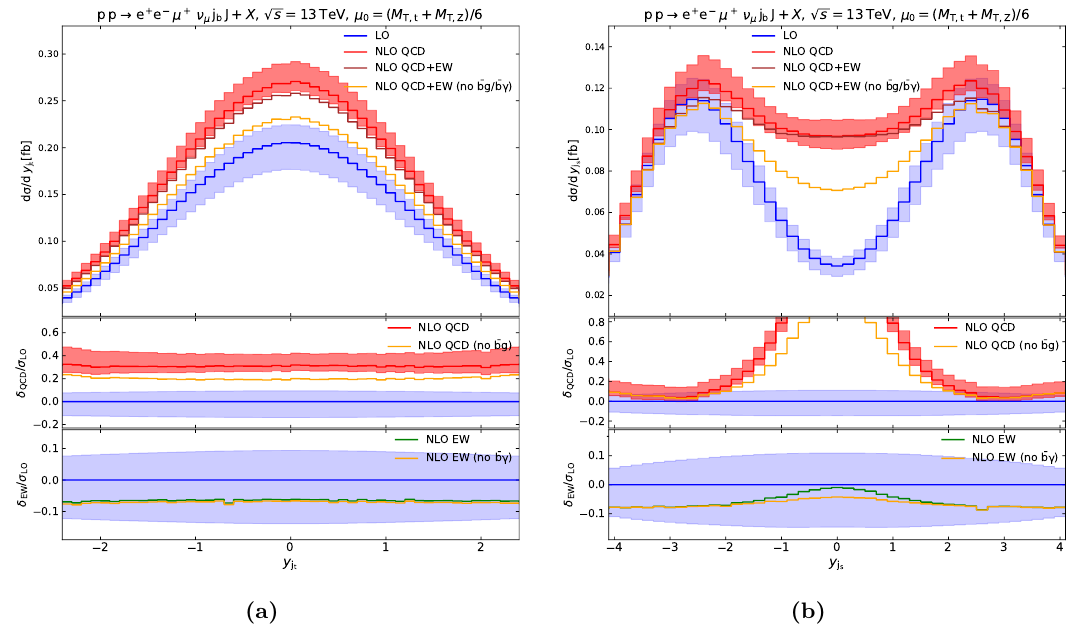
Figure 4. Rapidity distributions for the top-decay jet j b and spectator jet j s . See section 2.4 for the definition of these